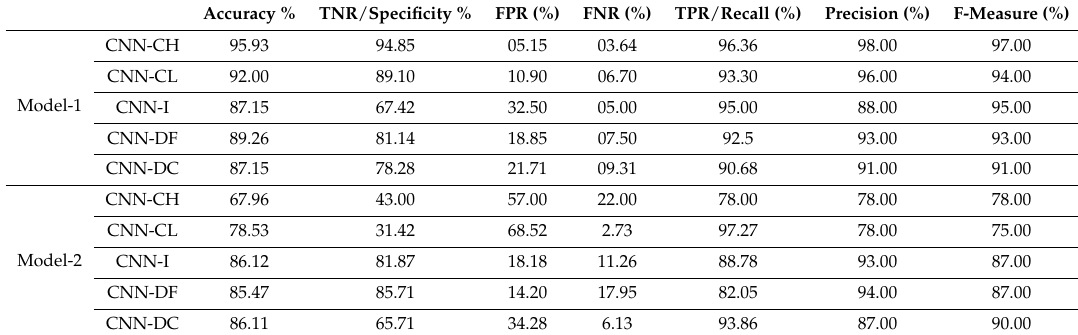
Table 4. Performance of various cases on 100 × dataset.